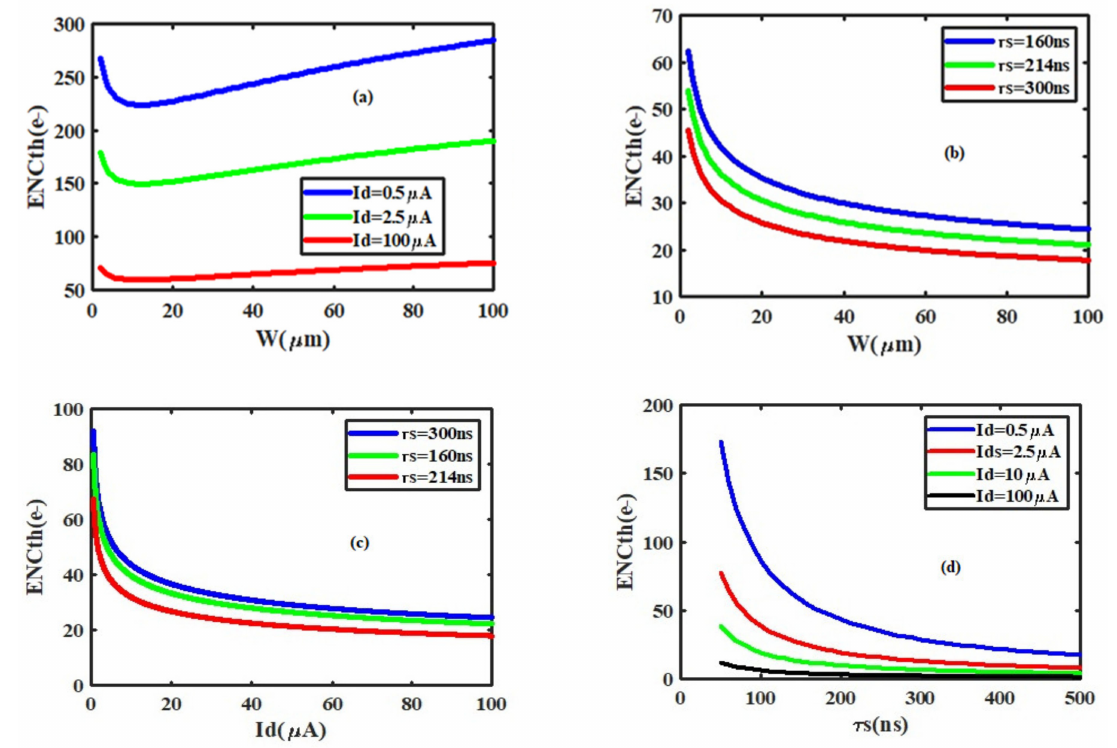
Figure 12. ENCth versus different design parameters: ( a ) as a function of W for different sets of the input device drain current; ( b ) as a function of W for different sets of the shaping time; ( c ) as a function of the input device drain current for various peaking time; ( d ) versus the peaking time for different sets of the input transistor drain current.